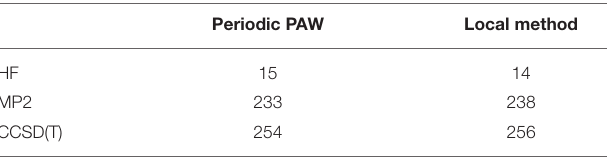
TABLE 2 | Calculated energy contributions to the adsorption energy of water on a (001) LiH surface model as obtained using different theories and techniques.